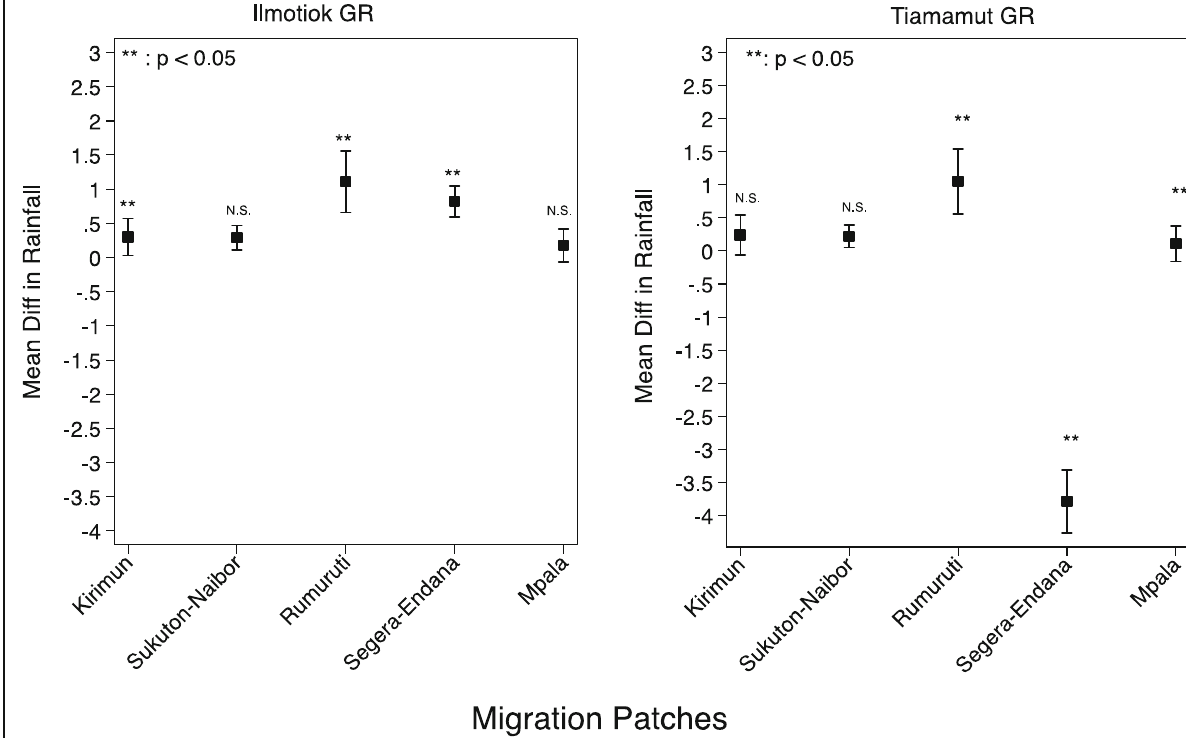
Figure 12 Results of a linear regression model predicting where pastoral families should migrate with their livestock based on the mean average difference in rainfall between the home patch (Ilmotiok or Tiamamut GR) and one of five potential migration patches (Kirimun, Sukuton-Naibor, Rumuruti, Segera-Endana, and Mpala). Mean difference in rainfall is reported in